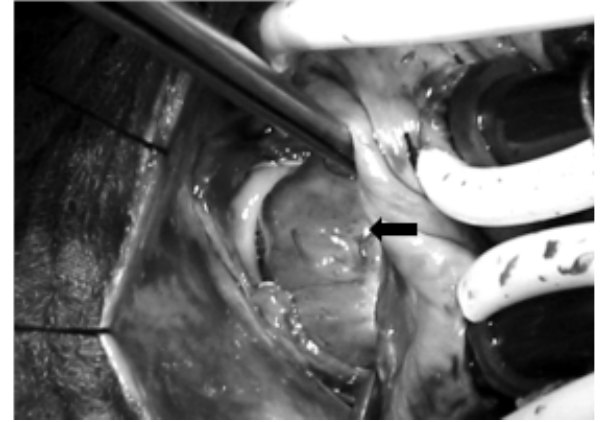
Fig. 2. Mixoma do átrio esquerdo (seta). Paciente sexo masculino, jovem, internado com edema agudo de pulmão. Exames revelaram volumoso mixoma de átrio esquerdo. Fotografia intra-operatória: toracotomia ântero-lateral direita, abertura do átrio esquerdo e exérese do tumor, pediculado no septo